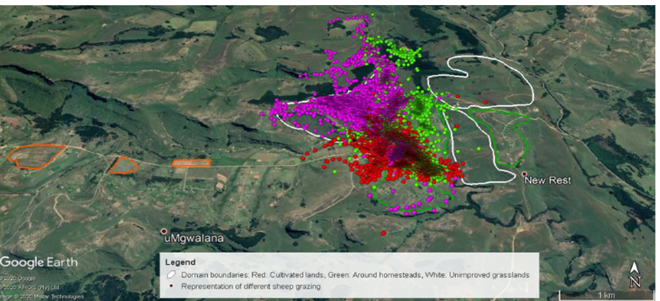
Figure 9. Google Earth plot showing the distribution of three different sheep grazing during the dry season.